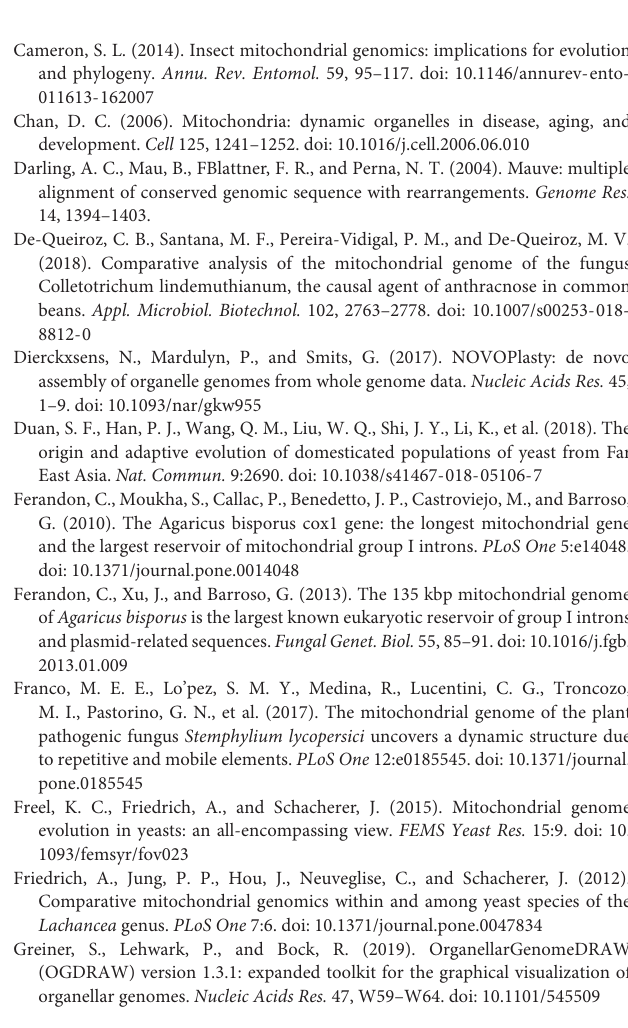
Supplementary Figure 1 | Position class (Pcl) analysis of nine conserved protein-coding genes (PCGs) within 10 Conidiobolus s.l. species. The phylogenetic tree is constructed by maximum-likelihood (ML) method based on 14 concatenated mitochondrial core proteins. Supplementary Figure 2 | Codon usage analyses of Conidiobolus s.l. mitogenomes. (A) C. chlamydosporus , (B) C. lichenicolus , (C) C. mycophagus , (D) C. polyspermus , (E) C. polytocus , (F) C. taihushanensis , (G) Capillidium heterosporum , (H) Conidiobolus sp., (I) Microconidiobolus nodosus , and (J) Neoconidiobolus thromboides